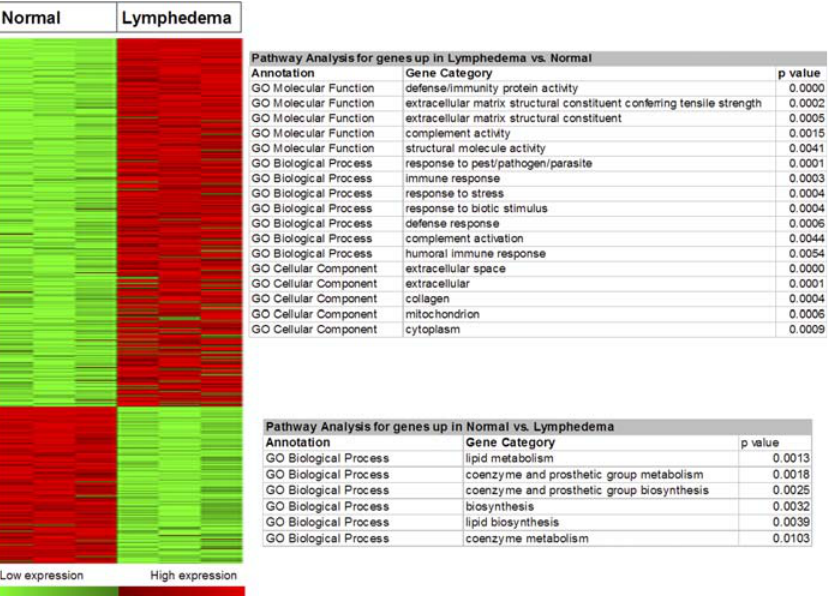
Figure 5. SAM Analysis of Microarray Data At an FDR of 5%, SAM analysis identified 429 upregulated genes in the lymphedema state versus 183 downregulated genes. There were no statistically significant differences between normal mice and surgical control animals (SAM, FDR , 25%). Enrichment analysis with the Fisher’s exact test (EASE software) demonstrated several statistically significant ontologies. DOI: 10.1371/journal.pmed.0030254.g005